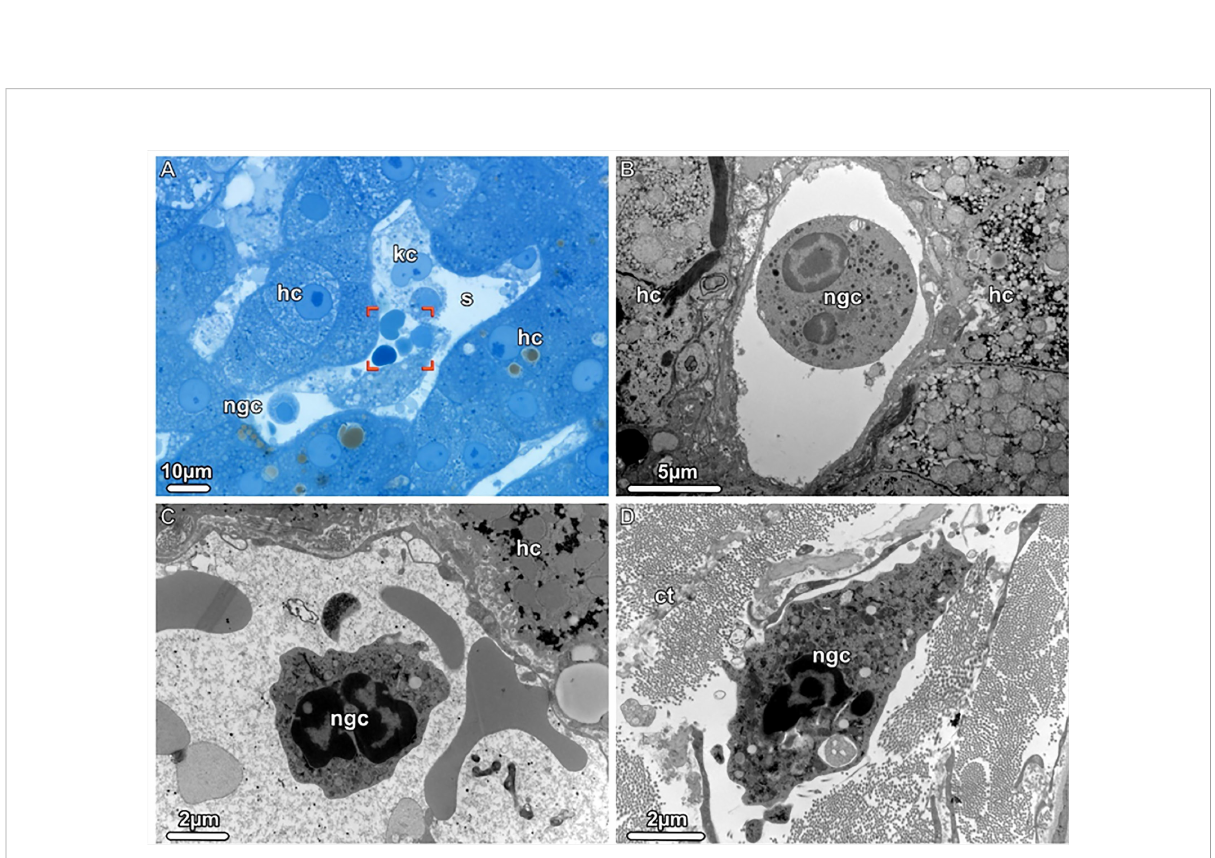
FIGURE 3 Neutrophil granulocytes detected during donor liver NMP, Light (LM) and Transmission electron microscopy (TEM). (A) LM. An overview of a liver sinusoid (s) containing Kupffer cells (kc), neutrophil granulocytes (gnc) and erythrocytes (brackets) is shown. (B, C) TEM. The sinusoids harbor mature as well as young neutrophilic granulocytes (ngc), both with a segmented nucleus. (D) TEM. A young neutrophil granulocyte (ngc) is seen in the dense connective tissue (ct) surrounding the liver, scattered between bundles of collagen fi brils. hc, hepatocytes.